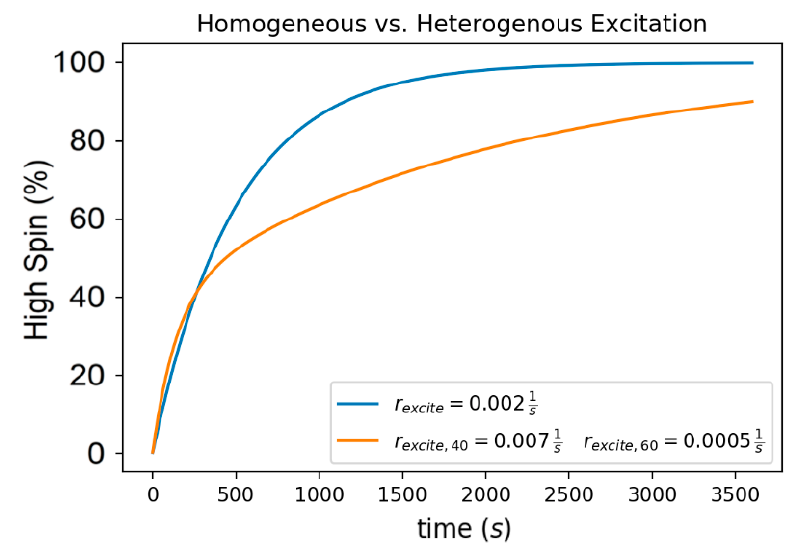
Figure 7. A simulation of the evolution of the high-spin state occupancy in the [Fe{H 2 B(pz) 2 } 2 (bipy)] molecular thin film assuming a simple excitation rate uniformly throughout the film (blue) and an inhomogeneous excitation process where 40% of the film is activated with one constant rate and 60% of the film at a lower rate that is 10% of the higher rate (orange).